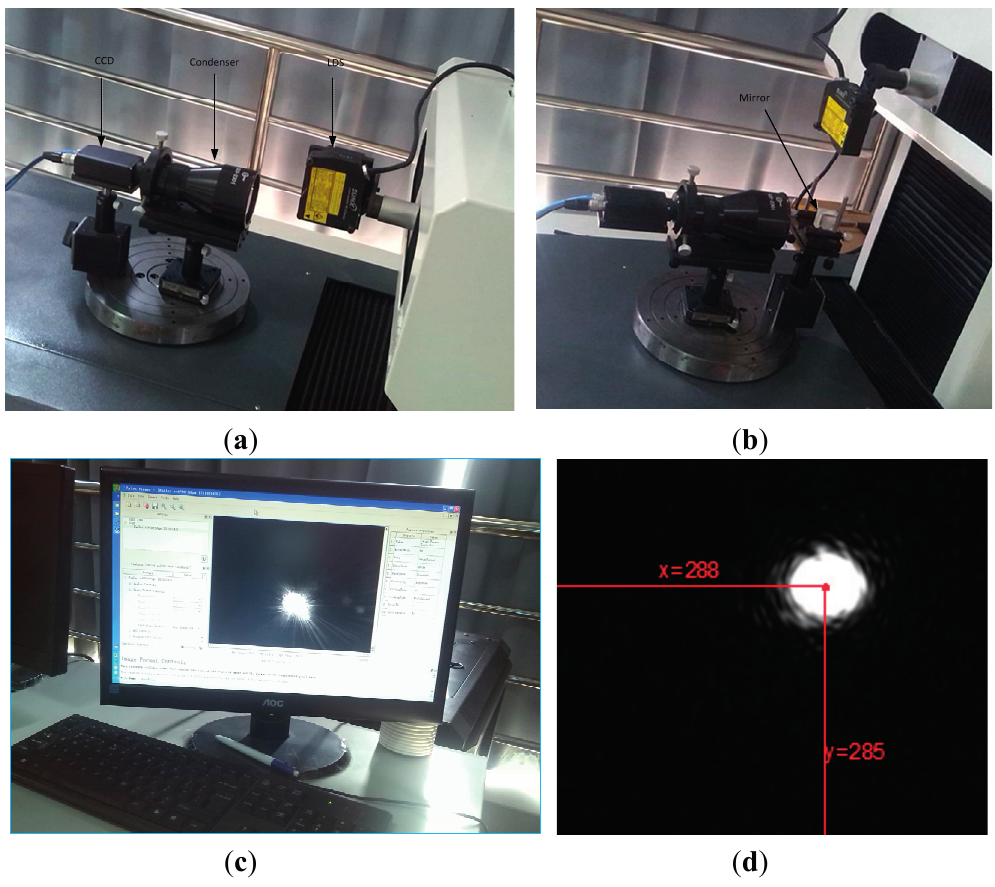
Figure 3. The LDS attitude adjustment. ( a ) Beam horizontal alignment; ( b ) Beam vertical alignment; ( c ) CCD acquisition display; ( d ) Light spot centroid